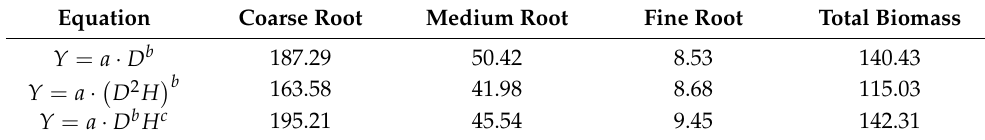
Table 3. Information statistics ( ∆ AICc = AICcnorm − AICclogn) of the likelihood analysis. Equation Coarse Root Medium Root Fine Root Total Biomass Y = a · D b